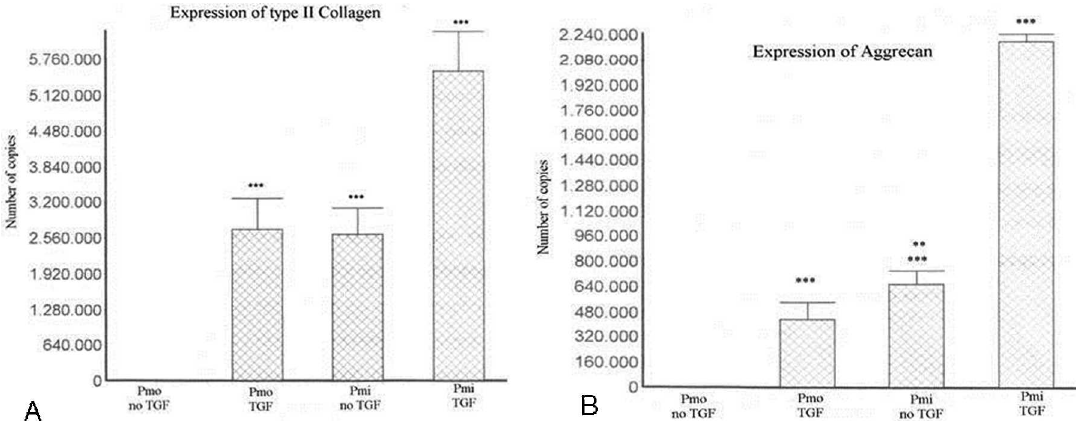
Figure 3A - The expression of type II collagen. RT-PCR analysis was conducted after three weeks of culturing of the periosteum-derived cells in monolayer and micromass systems. We observed that in the micromass culture, the addition of TGF- b 3 (P mo TGF and P mi TGF) increased the expression of type II collagen ( P , 0.001). No statistical difference was observed between cells grown in a monolayer in the presence of TGF b 3 (P mo TGF) and cells grown in a micromass without TGF- b 3 (P mi no TGF) ( P . 0.05 ) . B. The expression of aggrecan. RT- PCR analysis was conducted after three weeks of culturing of the periosteum-derived cells in both monolayer and micromass systems. We observed that in the micromass culture, the cells grown in the presence of TGFP- b 3 exhibited increased expression of Aggrecan ( P , 0.001) compared to the cells grown in the monolayer with TGF- b 3 (P mi TGF and P mo TGF). The cells in the micromass culture without TGF- b 3 (P mi no TGF) expressed less aggrecan compared to the cells in the monolayer culture with TGF- b 3 (P mo TGF), ( P ,